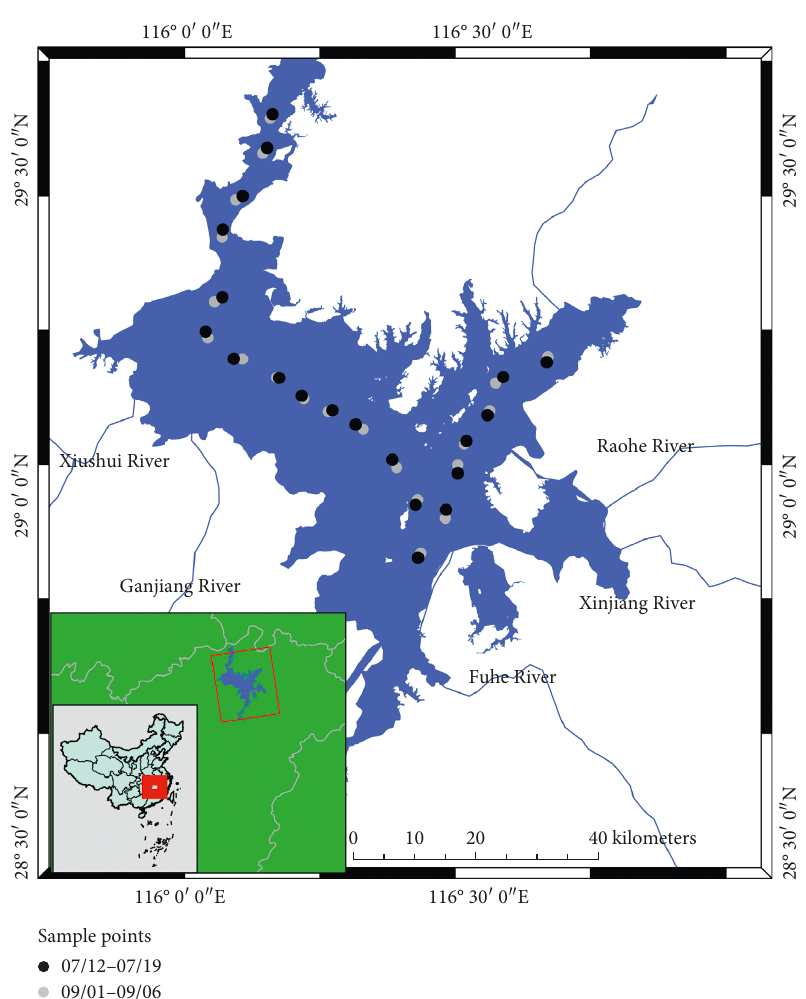
Figure 1: Location of Poyang Lake in China and sample sites over the lake during study